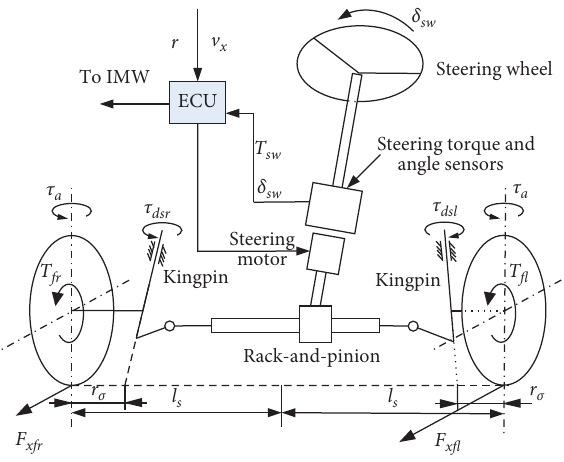
Figure 1: System model with differential